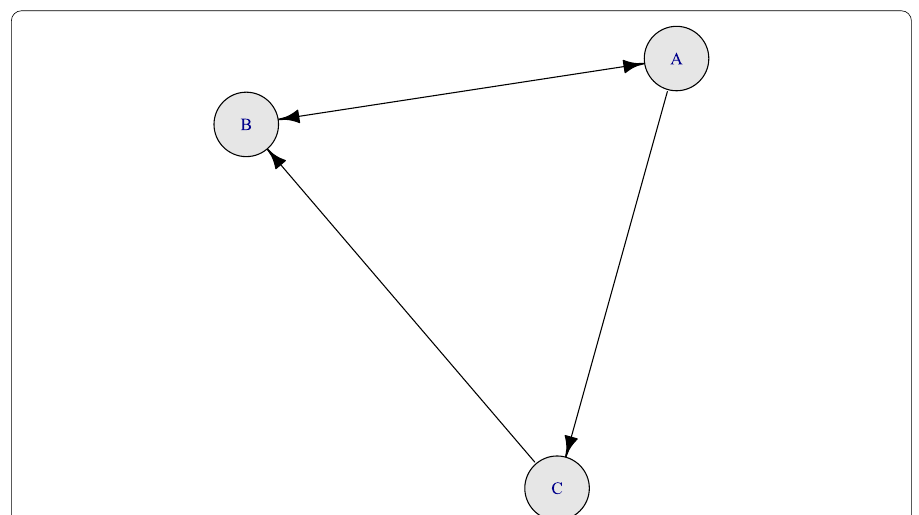
Fig. 1 Toy directed network with connections between three individual students. In this network A reports working with B and C, B reports working with A, and C reports working with B. Note that if the network were converted to an undirected network, network properties like degree have a significanly different